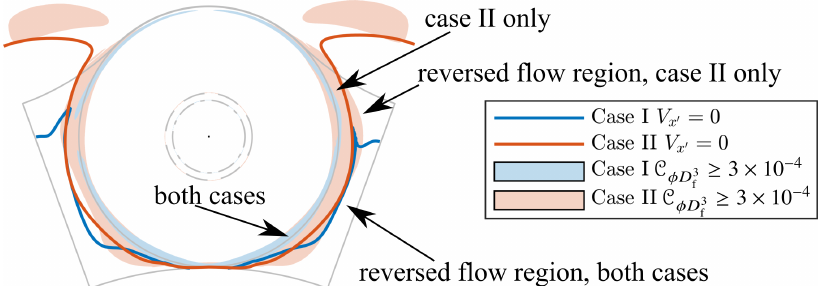
= 0 isolines, near nozzle exit, location as Figure 11. Reversed flow extent, indicated by the V x (cid:48) indicated in Figure 12. The high dissipation regions are shaded in colour, with case I overlaid onto case II. The exhaust geometry is in grey, with the different plug profiles: case I , and case II